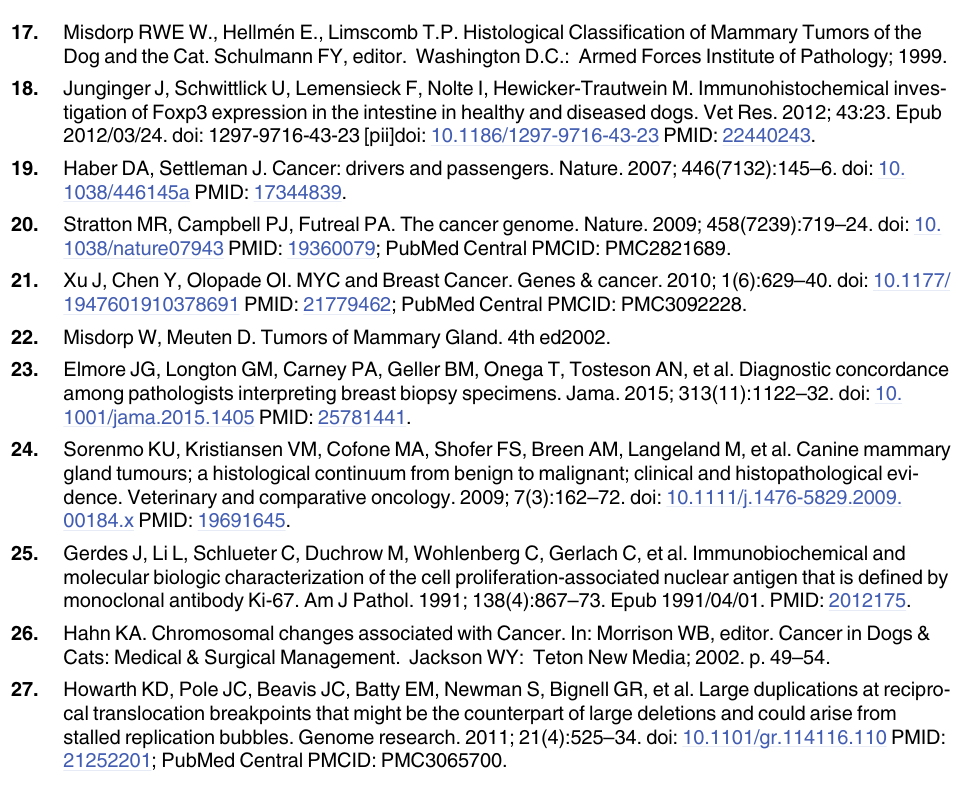
PLOS ONE | DOI:10.1371/journal.pone.0131280 July 1,